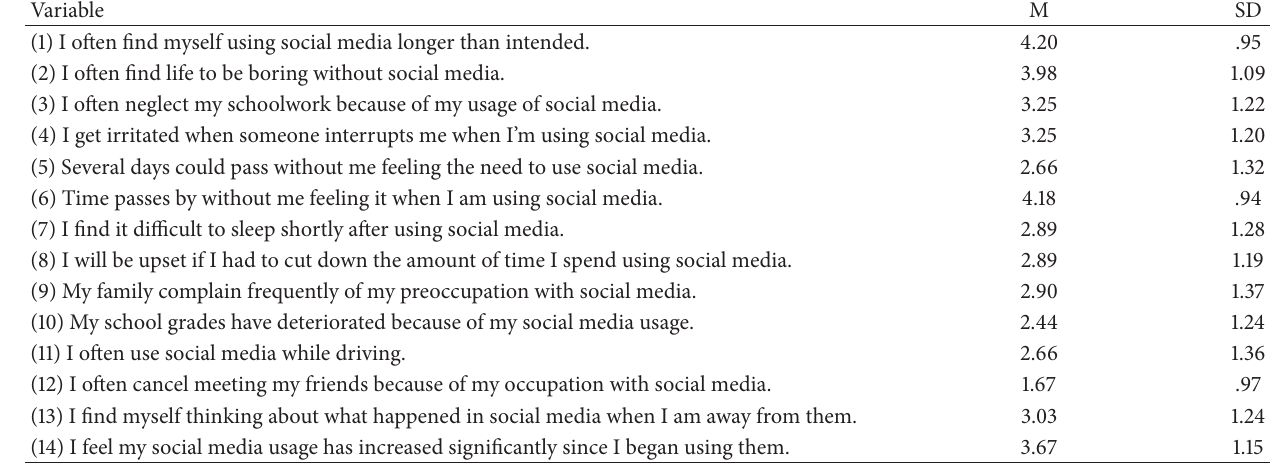
Table 1: Means and standard deviations of Social Media Addiction Scale (original in Arabic).